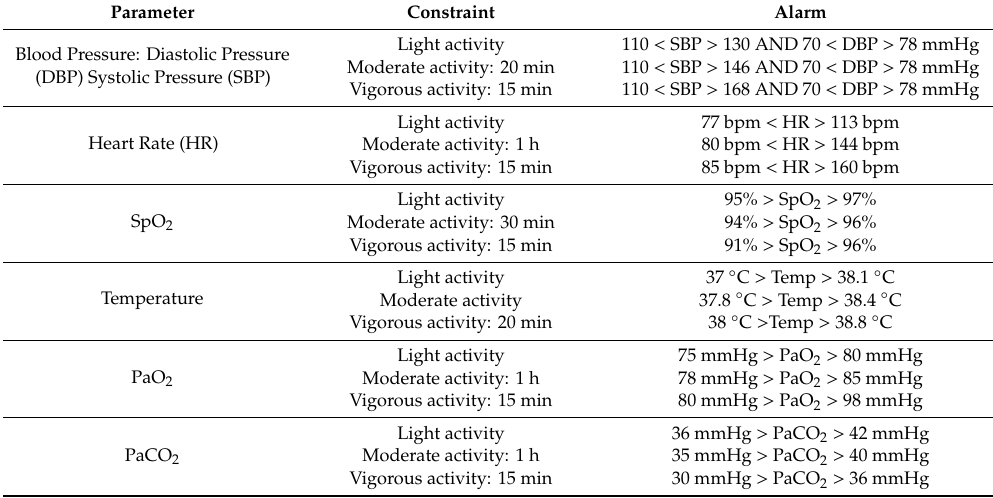
Table 8. Biomarker alarms and constraints for a specific